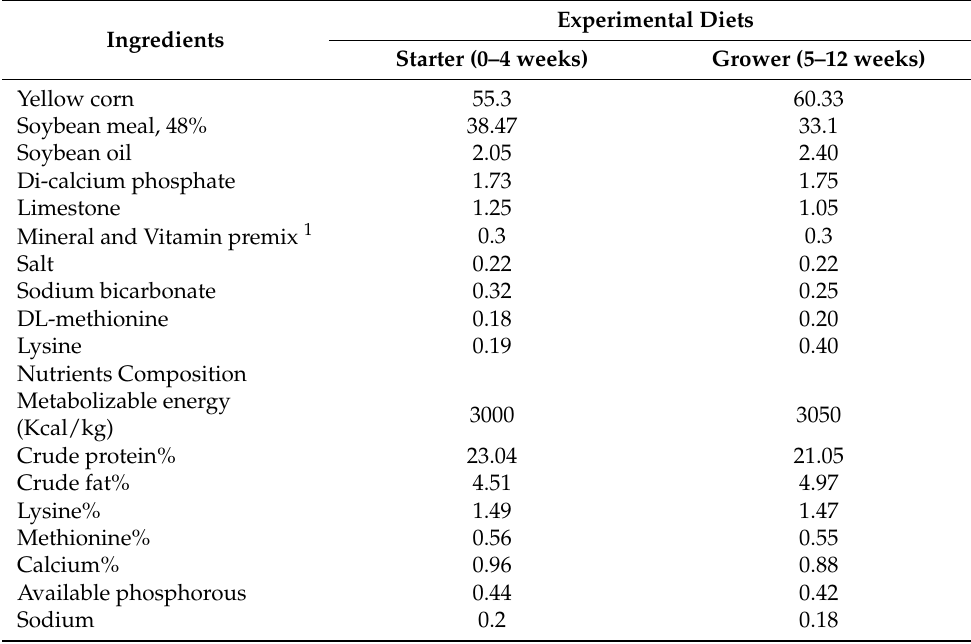
Table 1. Ingredients and calculated chemical composition of the basal diet